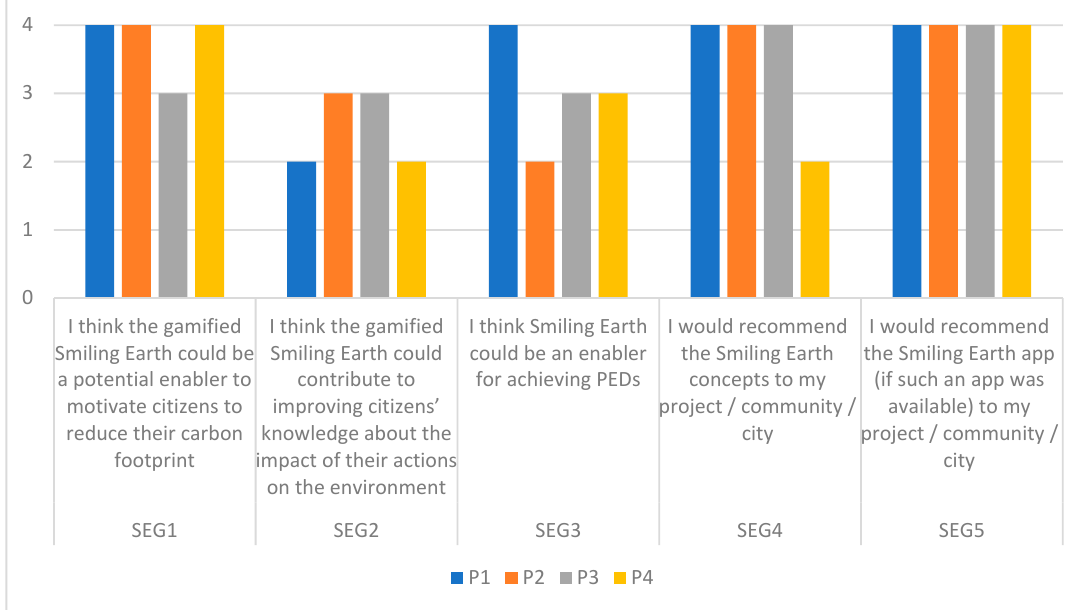
Figure 8. Gamified Smiling Earth for raising awareness in communities.